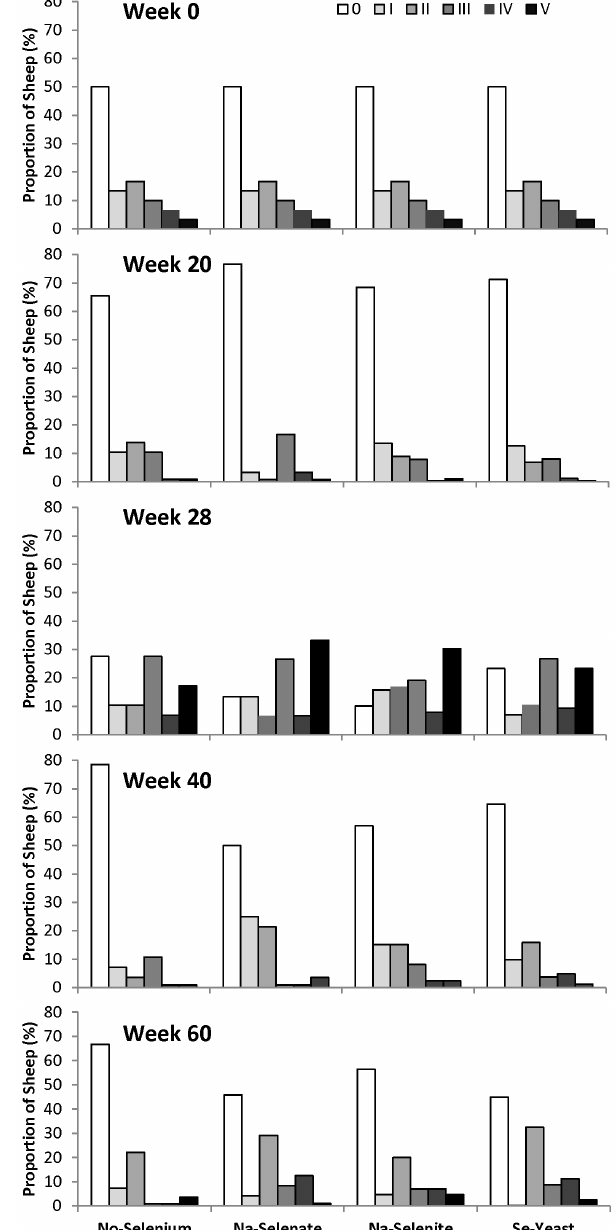
Figure 5. The effect of Se-source on foot rot (FR) severity in sheep. Foot rot severity was assessed after 0, 20, 28, 40, and 60 wk of Se supplementation in ewes receiving no Se treatment, Na-selenate, Na- selenite, and Se-Yeast for 62 wk. All dosage groups were combined for each chemical source of Se treatment. The proportion of sheep (%) in each FR-severity category within each treatment group is shown (scale 0 to V; with no FR = 0 being the lowest category). The scoring and categorization for FR is described in detail in the Materials and Methods. There were no consistent effects of Se source on FR prevalence and severity across